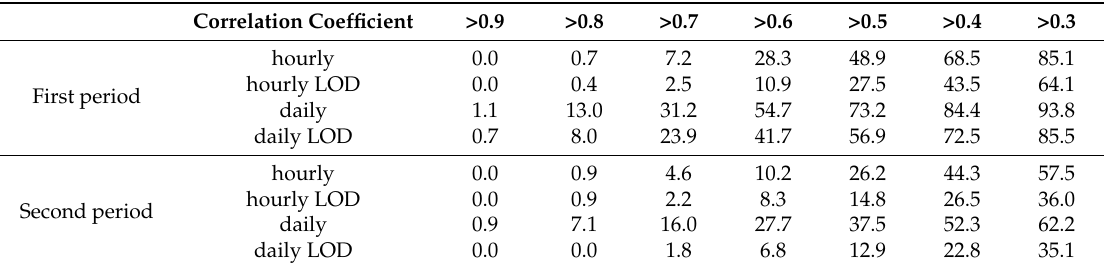
Table 3. Percentage of Pearson correlation coefficients in the correlation matrixes of Speck PM concentrations calculated from hourly and daily averages, from the original and LOD corrected data (denoted as LOD in the table).